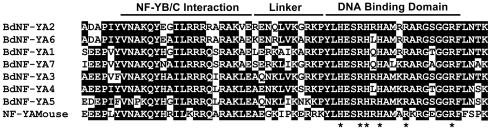
BdNF-YA family multiple alignment.Multiple alignments were performed by ClustalX [51] as implemented by Molecular Evolutionary Genetics Analysis (MEGA) software, version 4.0 [52]. Amino acid sequences corresponding to the conserved regions for all BdNF-YA and the Mus musculus NF-YA (NF-YAMouse) are shown. NF-YAMouse is included as an outgroup to root the phylogenetic trees (below) and for comparison. Amino acids in black boxes/white letters are identical in at least 50% of all aligned sequences. Asterisks below H and R residues represent amino acids known to be specifically required for DNA binding [53]. Regions identified as required for DNA binding or subunit interactions for NF-YA, as well as the NF-YB and NF-YC subunits in Figures 2 and 3 below, were previously defined in the yeast and mammalian literature [10], [11], [53], [54], [55], [56], [57], [89].